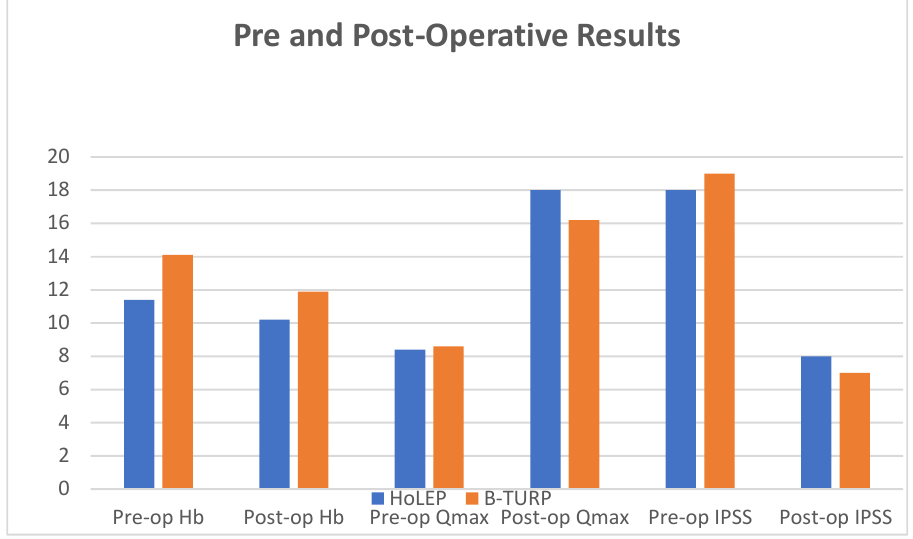
Figure 1. Pre-operative and post-operative results.